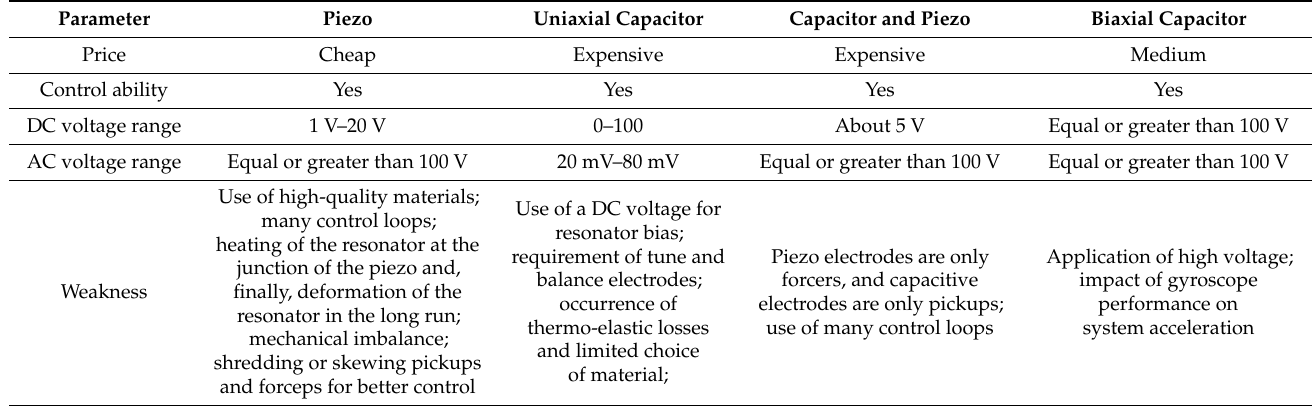
Table 9. Comparison of important gyroscopic parameters by type of